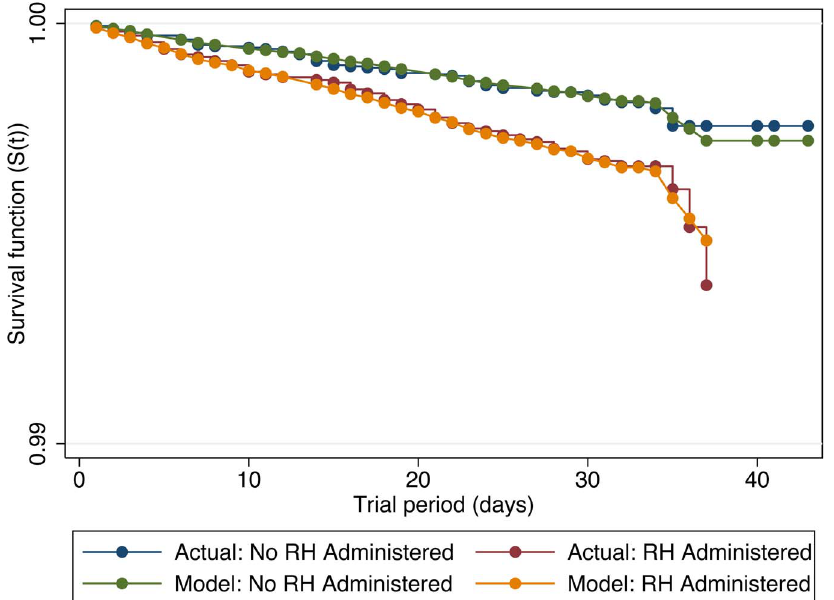
Figure 2. Survival analysis for cattle administered a b -adrenergic agonist. Kaplan-Meier non-parametric (actual) and Cox proportional hazards (predicted) survivor functions (S(t)) for cattle administered a diet containing ractopamine hydrochloride (RH) compared to a diet without RH in Company C.